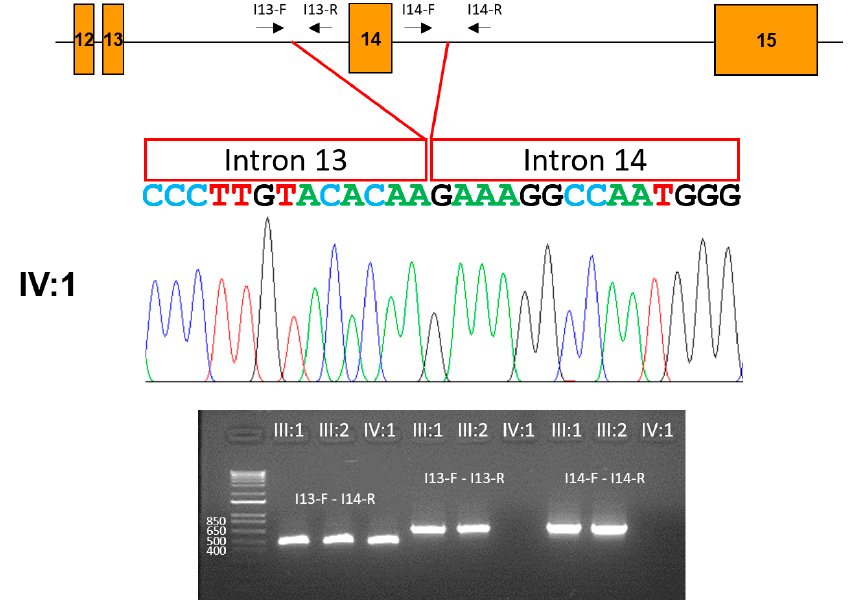
Figure 8. Characterization of the deletion. A partial gene diagram is shown at the top. Exons are indicated with orange boxes, and exon numbers are in the boxes. Introns are shown as horizontal lines. Locations and directions of the primer binding sites are shown above the introns. Deletion points are indicated with red lines. The sequencing chromatogram of the proband is shown in the middle. The intron 13 and 14 sequences are shown as boxes above the nucleotide sequences. The agarose gel image is shown at the bottom. PCR reaction with I13-F and I14-R results in a 475 bp band from the mutant allele but a 4169 bp band from the wild-type allele. PCR amplifications within intron 13 (I13-F and I13-R, 656 bp) and 14 (I14-F and I14-R, 711 bp) did not produce PCR bands from the proband.